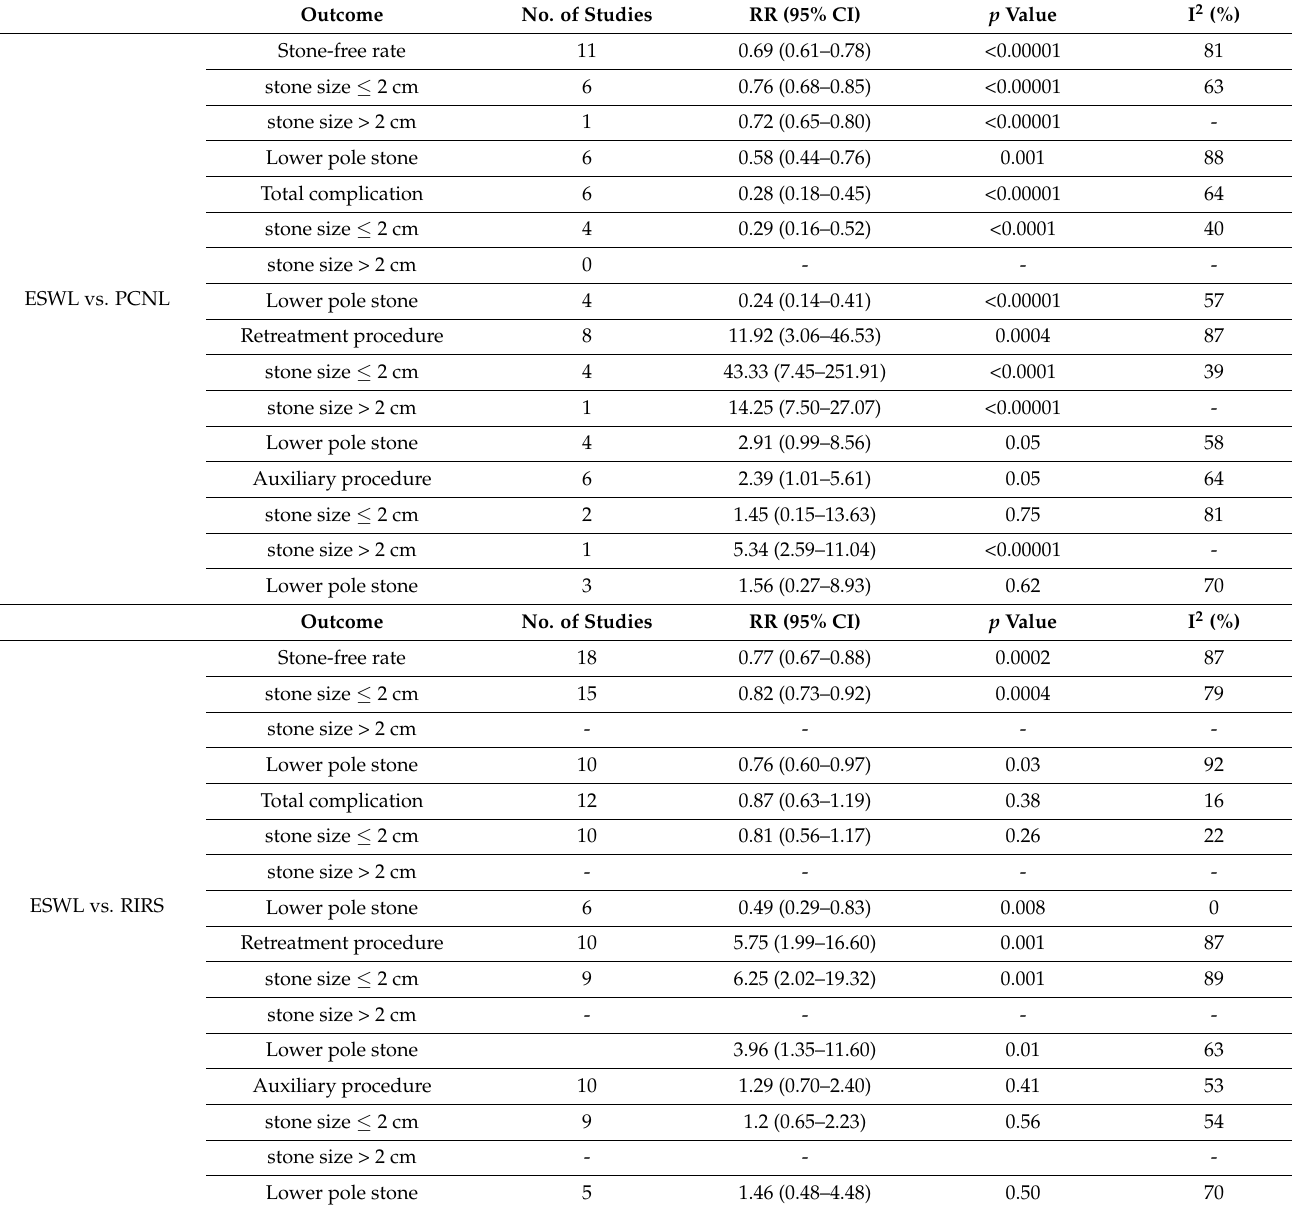
Figure 10. Meta-analysis ( A ). Auxiliary procedure (stone size ≤ 2 cm): ( a ) ESWL vs. PCNL; ( b ) ESWL vs. RIRS; and ( c ) PCNL vs. RIRS. Meta-analysis ( B ). Auxiliary procedure (stone size > 2 cm): ( a ) ESWL vs. PCNL; and ( b ) PCNL vs. RIRS. Table 2. Summary of results.